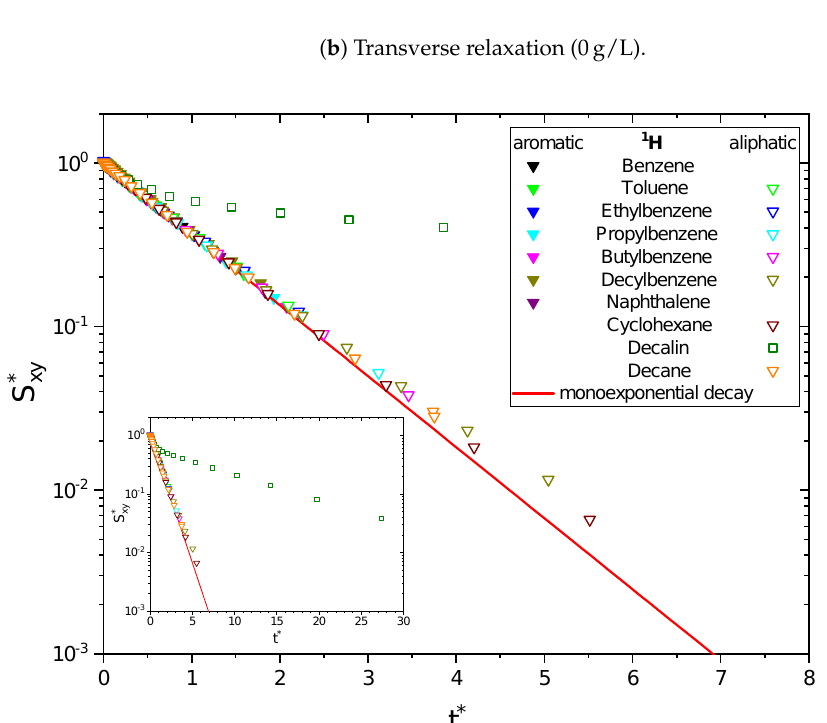
− 1 1,2 and the signal is